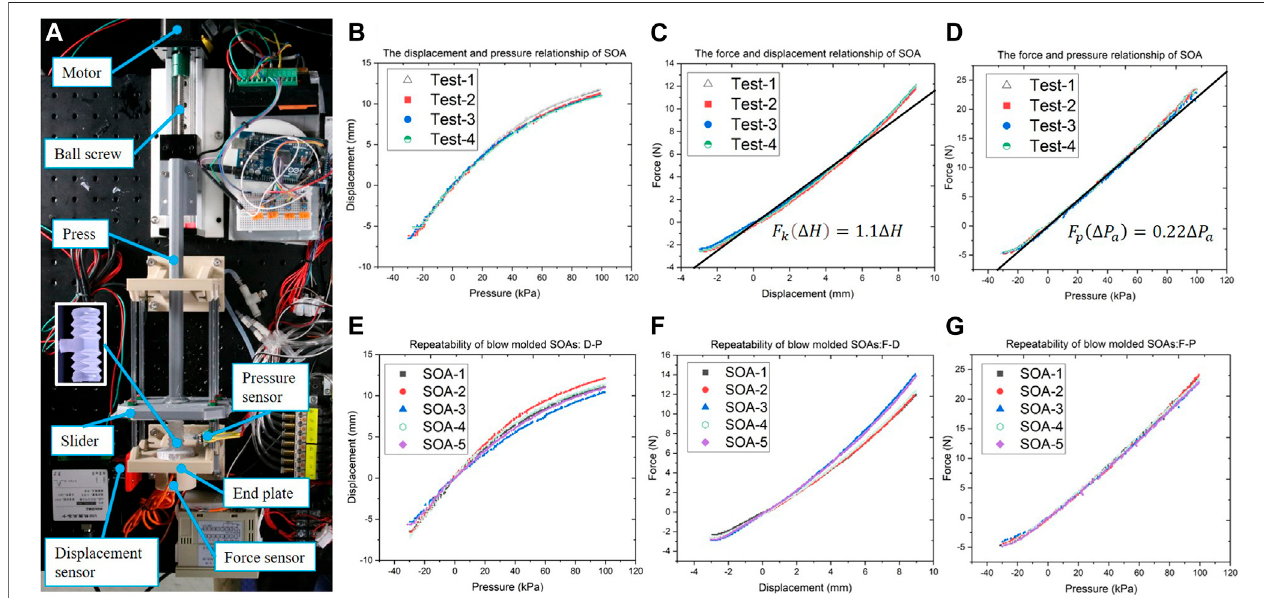
FIGURE 6 | Tests on the soft origami actuator, (A) the test setup that measures the displacement, air pressure, and force; the test results of single SOA: (B) the displacement – pressure relationship, (C) the force – displacement relationship, (D) the force – pressure relationship; the repeatability tests on fi ve SOAs of 1.9 g weight: (E) the displacement – pressure relationship, (F) the force – displacement relationship, (G) the force – pressure relationship.